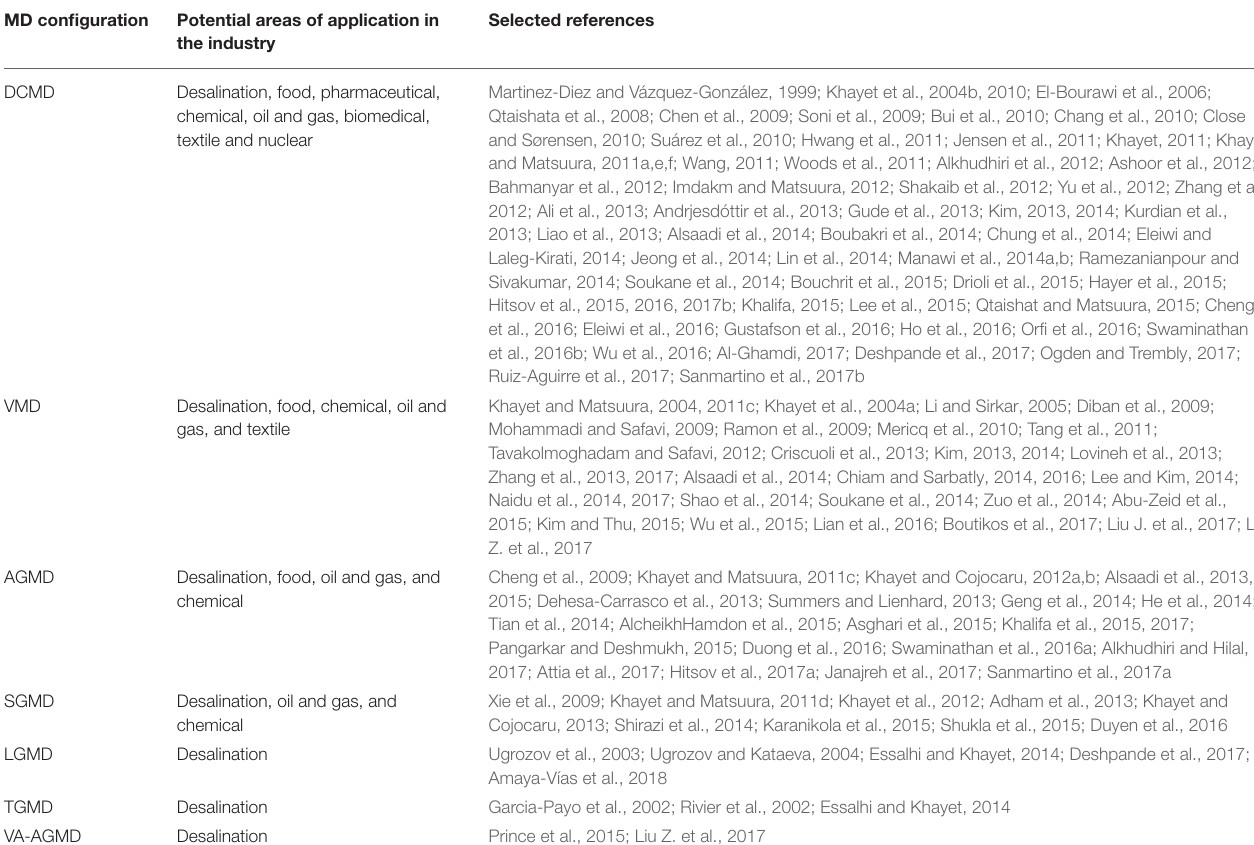
TABLE 1 | Potential areas of application for MD